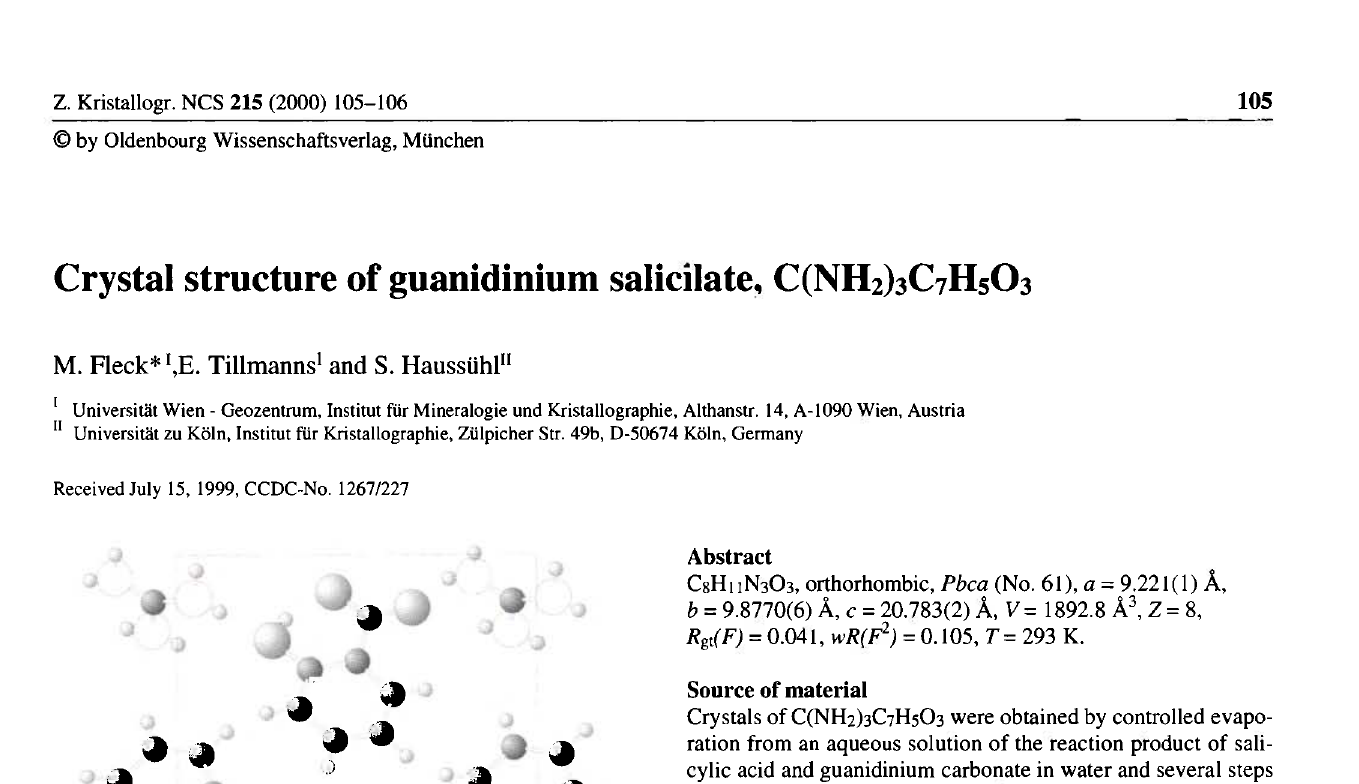
Table 1. Data collection and handling. Crystal: